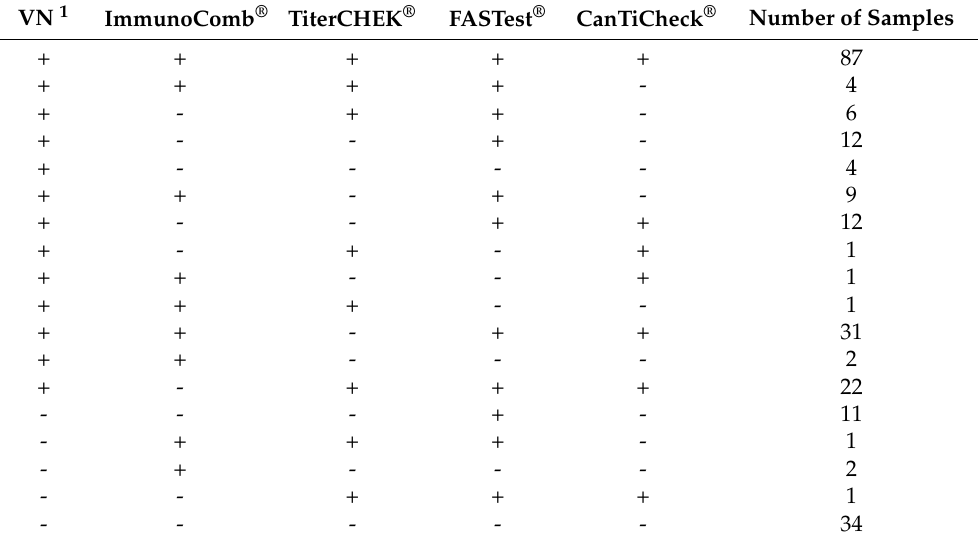
Table 7. Subgroups of virus neutralization test results and the respective results of the four point-of- care tests for the detection of antibodies against canine parvovirus all dogs. VN 1 ImmunoComb ® TiterCHEK